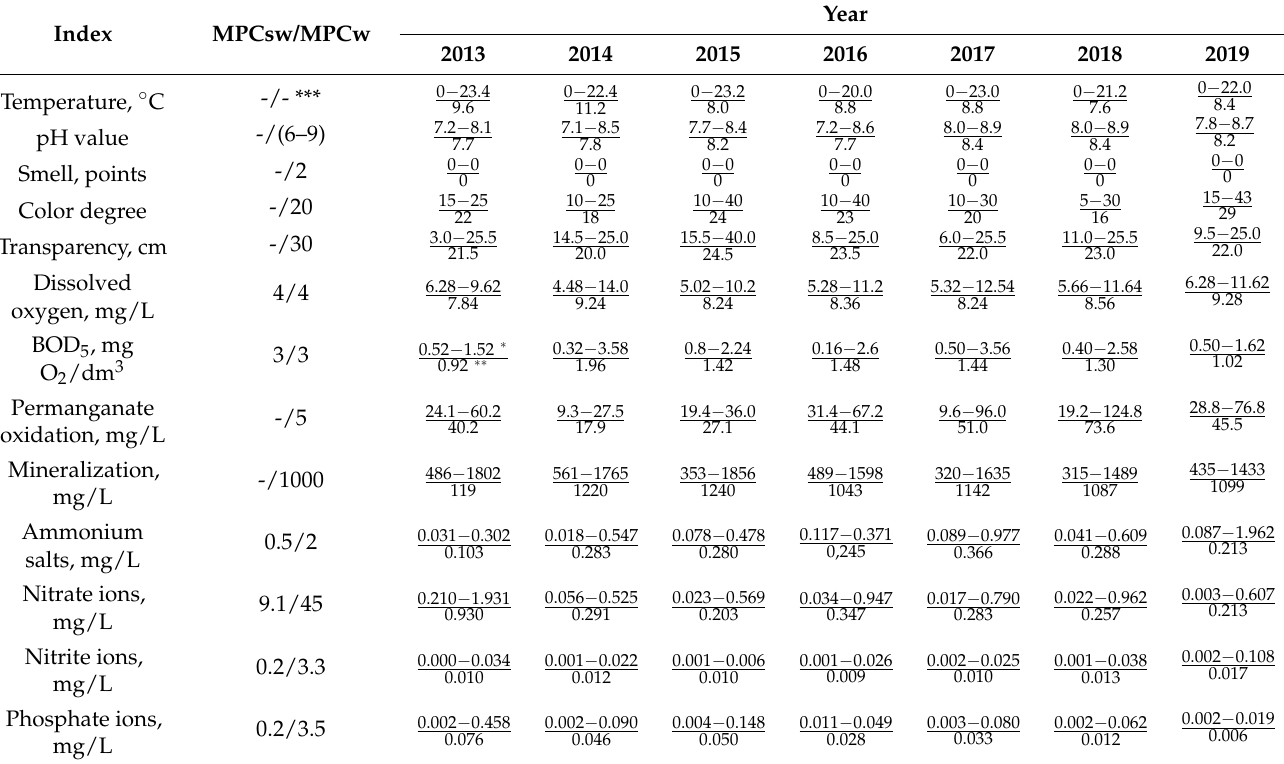
Table 3. Organoleptic, generalized and biogenic elements of the Ishim River